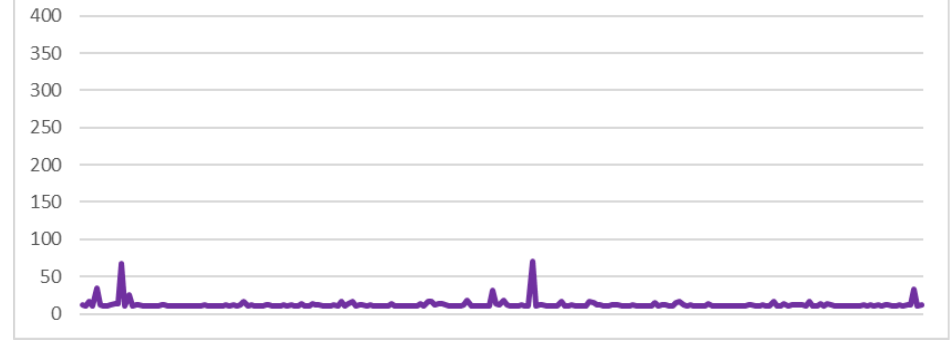
Figure 12. Time delay between the application output and the DSS output (Δt 23 vs. ms).